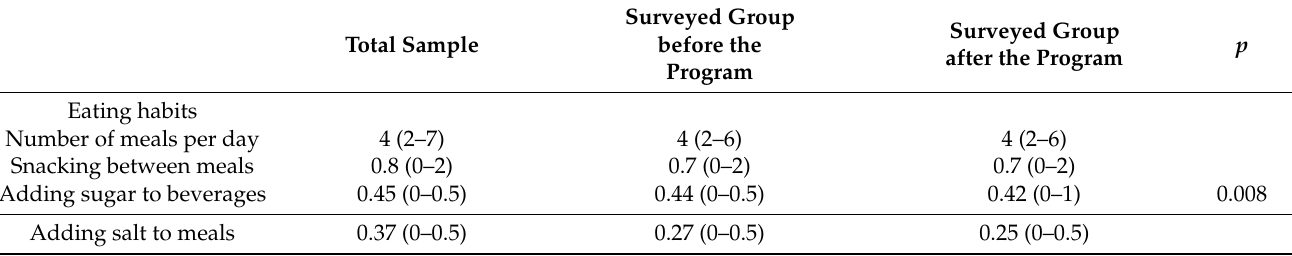
Table 4. Eating habits in the family in the studied population and in the surveyed group before